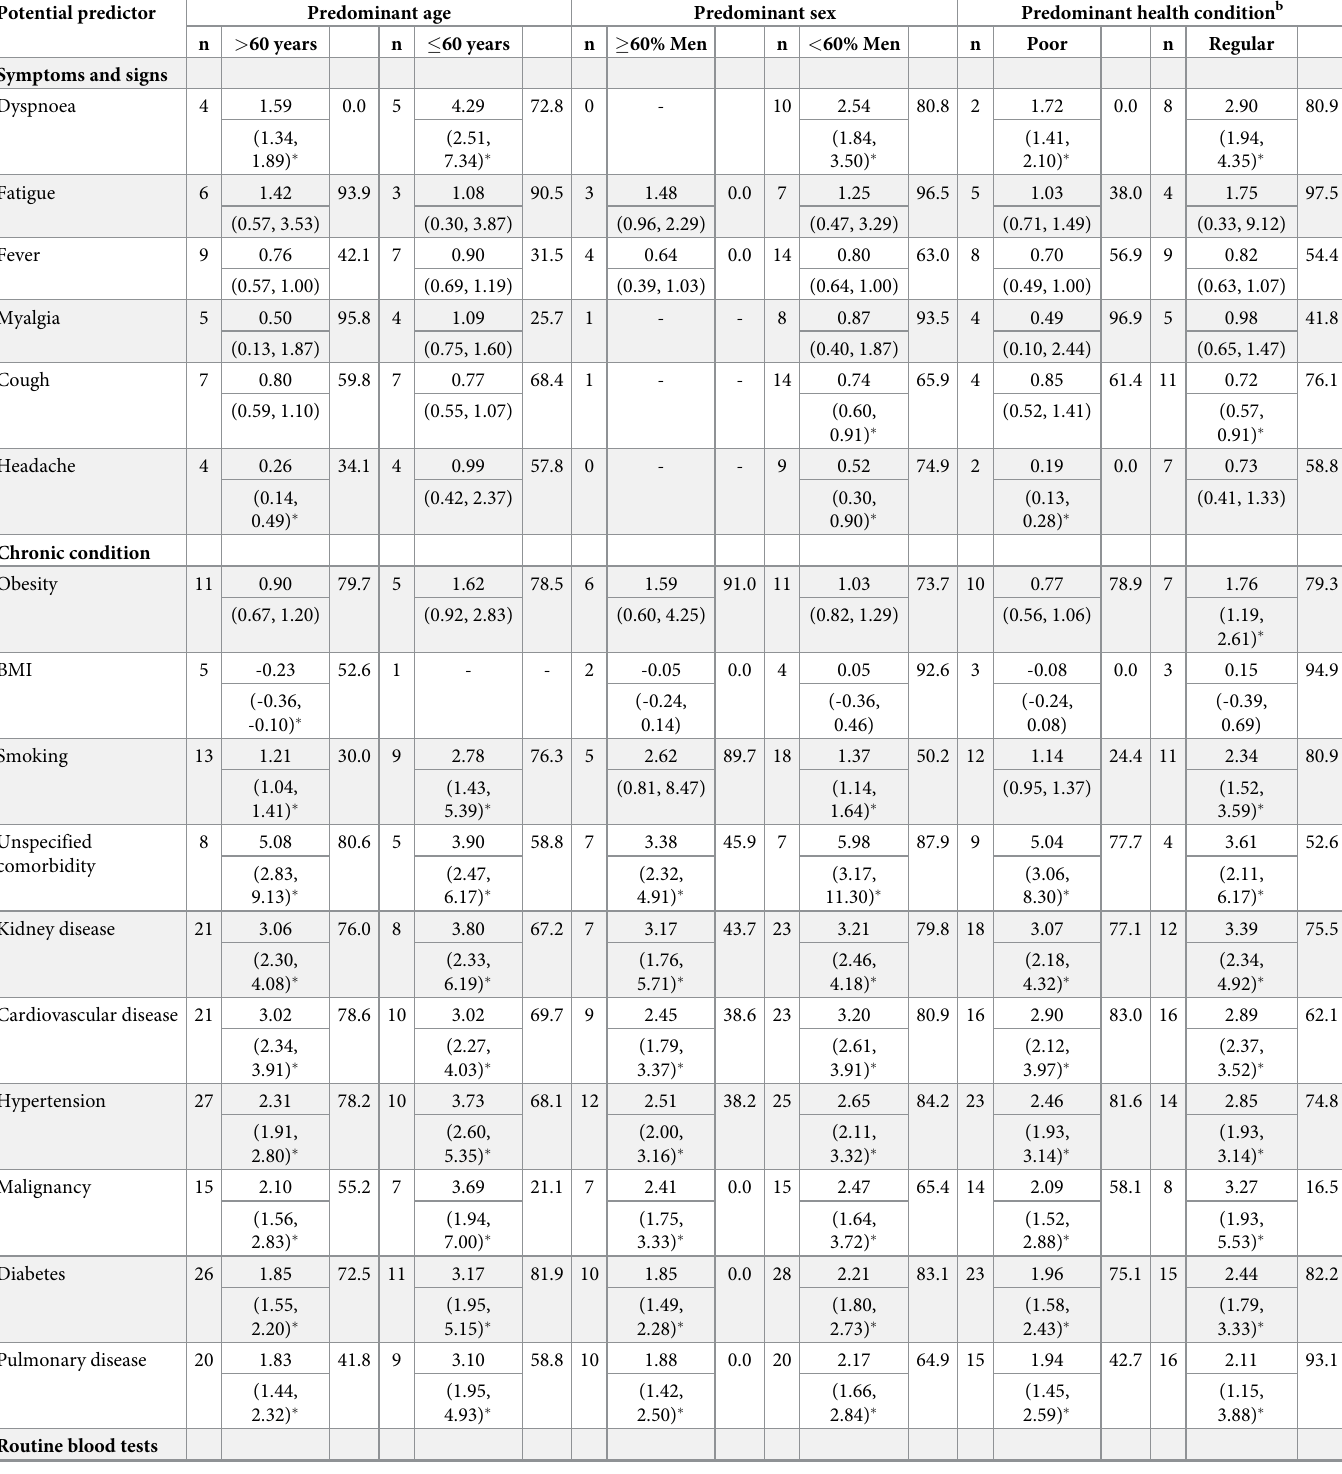
Table 4. Subgroup meta-analyses a of sociodemographic and clinical potential predictors of in-hospital mortality according to the predominant age, sex and health condition of the patients. Potential